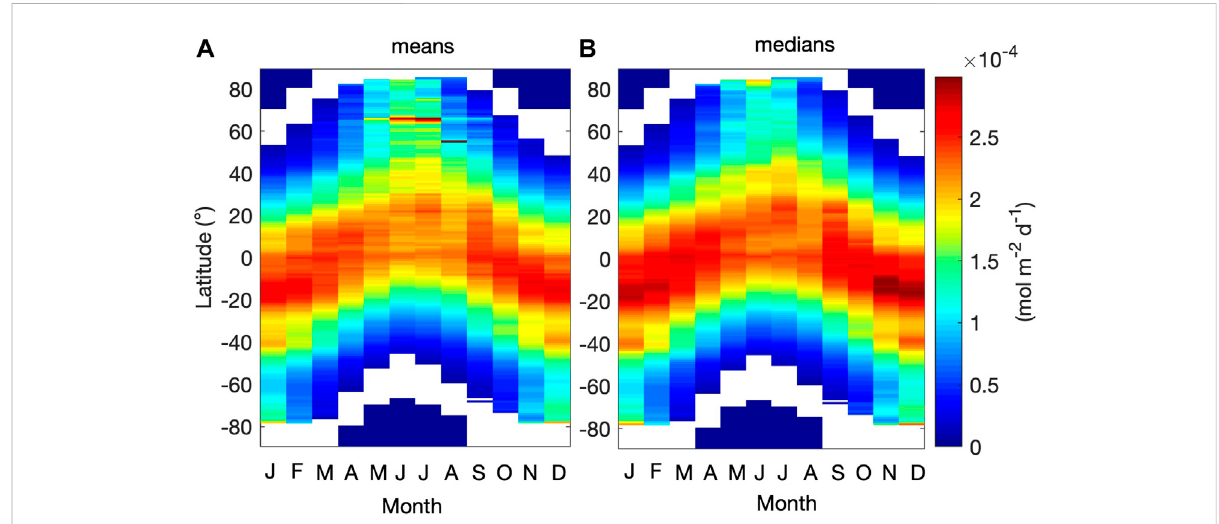
FIGURE 7 Hövemoller diagrams comparing the monthly (A) average and (B) median values of P H